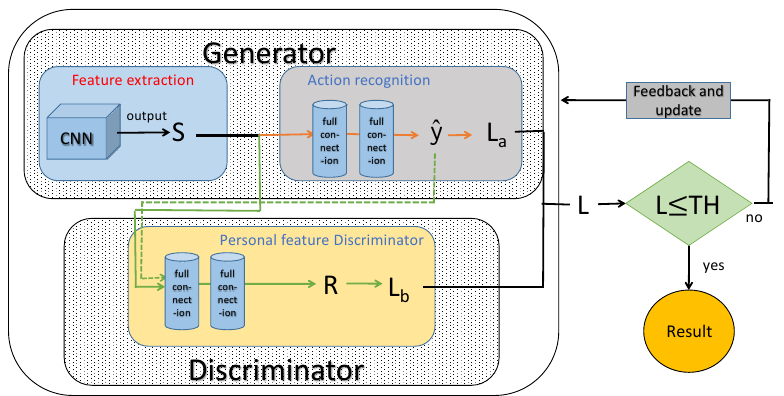
Figure 7. Action-recognition method in WiPg.